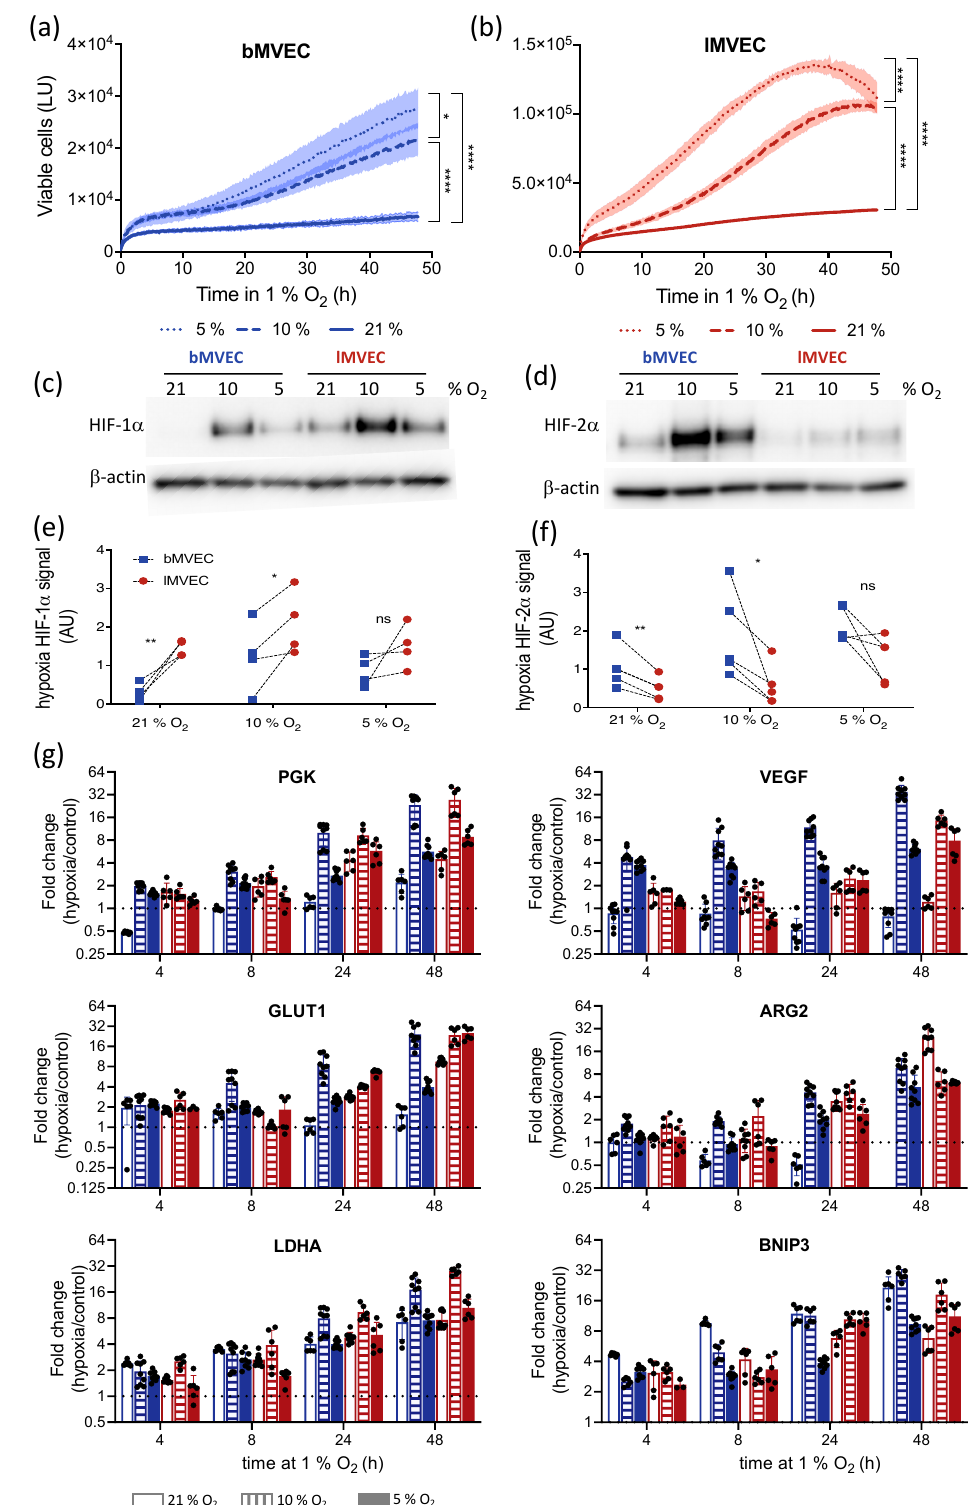
Figure 2. MVEC response to hypoxia is organ-specific and dependent on O 2 priming. Real-time viability of ( a ) brain (blue) and ( b ) lung (red) MVEC maintained at 21%, 10% or 5% O 2 and transferred to hypoxia (1% O 2 ) at t = 0 was measured using a Real-Time Glo assay (Promega) ( n = 3). Shaded areas show SD, and statistical differences were assessed by 2-way ANOVA with Holm–Sidak’s